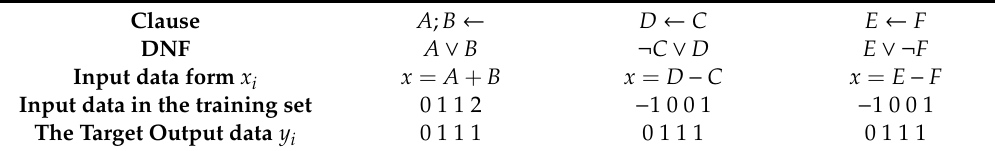
Table 1. The input data form and the training data of P 2 SAT in Radial Basis Function Neural Network